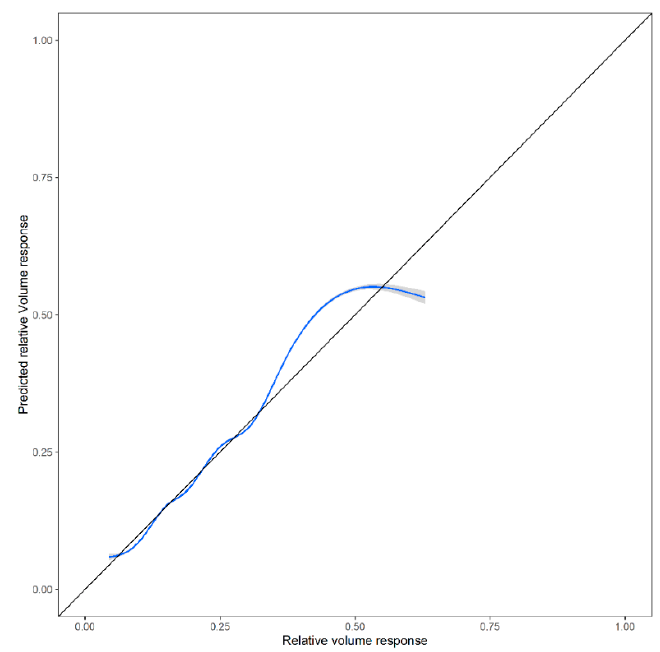
Figure 6. Performance of Equation (16), smooth line of observed stand-level relative volume responses vs. estimated (predicted) stand-level relative volume responses. The validation dataset originated from 1000 random samples generated through the non-parametric bootstrapping technique.